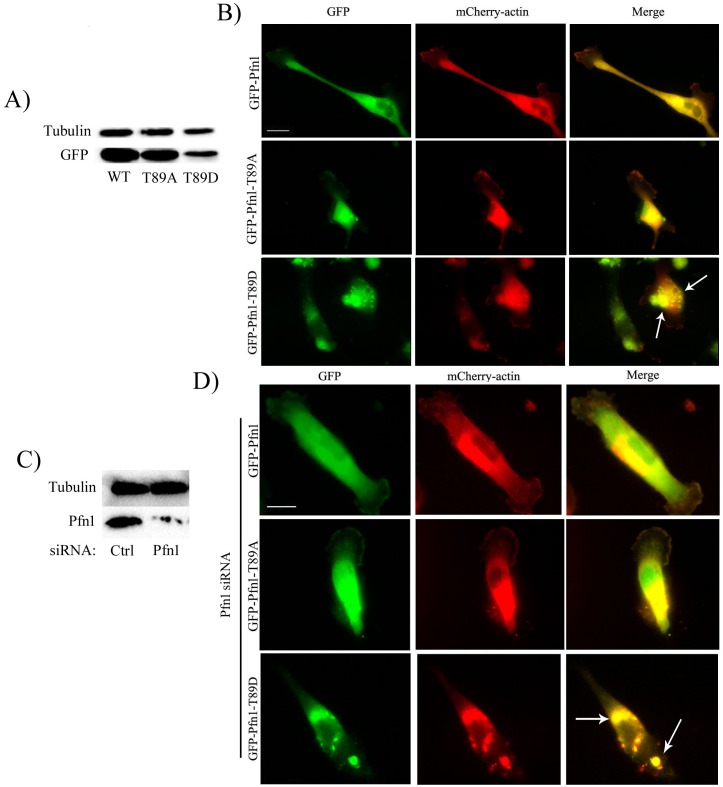
T89D-Pfn1 co-clusters with actin in cells.A) Lysates prepared from MDA-231 cells expressing indicated EGFP-fused Pfn1 constructs were immunoblotted with anti-GFP antibody to show the relative levels of various EGFP-Pfn1 constructs (tubulin blot serves as the loading control). B) Fluorescence images of MDA-231 cells expressing indicated EGFP-fused Pfn1 and mCherry-actin demonstrate mCherry-actin clustering at the sites of T89D-Pfn1 aggregates (arrows; Scale bar—20 μm). C) Fluorescence images of MDA-231 cells co-expressing mCherry-actin and EGFP-Pfn1-T89D, and treated with Pfn1 siRNA reveal mCherry-actin:T89D-Pfn1 co-clusters (arrows; Scale bar—20 μm). Pfn1 immunoblot alongside confirms near complete loss of endogenous Pfn1 expression in Pfn1-siRNA treated cells when compared against control siRNA transfected cells (tubulin blot—loading control).